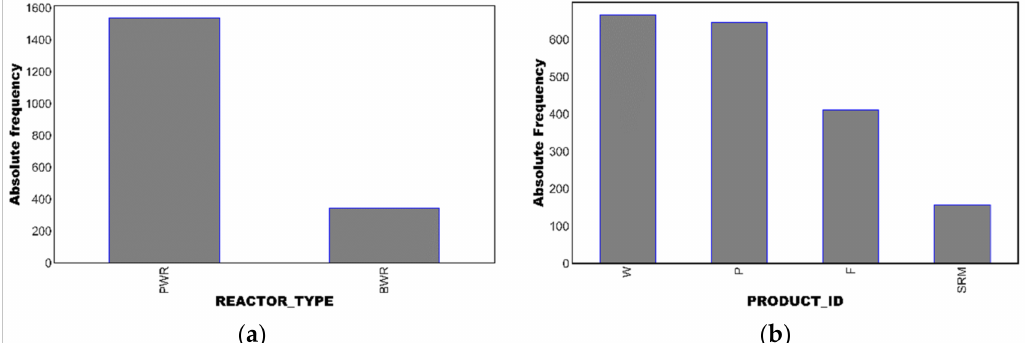
Figure 2. Barplots showing the distribution of the two nominal features in the PLOTTER database. ( a ) Reactor type (PWR: pressurized water reactors or BWR: boiling water reactors) and ( b ) product type (welds, plates, forgings and SRMs: standard reference